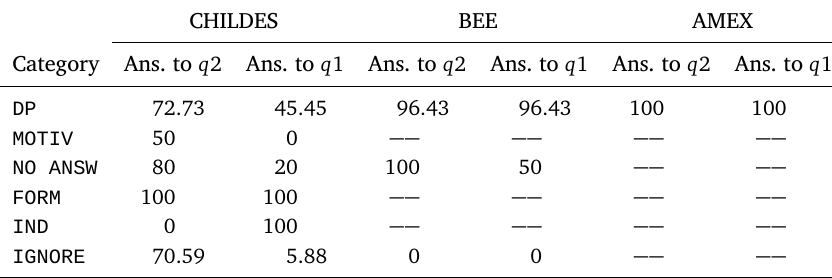
Table 8. In terms of answer analysis, task-oriented dialogues are inter- Table 8: Answers provided to query responses (CHILDES, BEE and AMEX) in % of the total CHILDES BEE AMEX Category Ans. to q 2 Ans. to q 1 Ans. to q 2 Ans. to q 1 Ans. to q 2 Ans. to q 1 DP